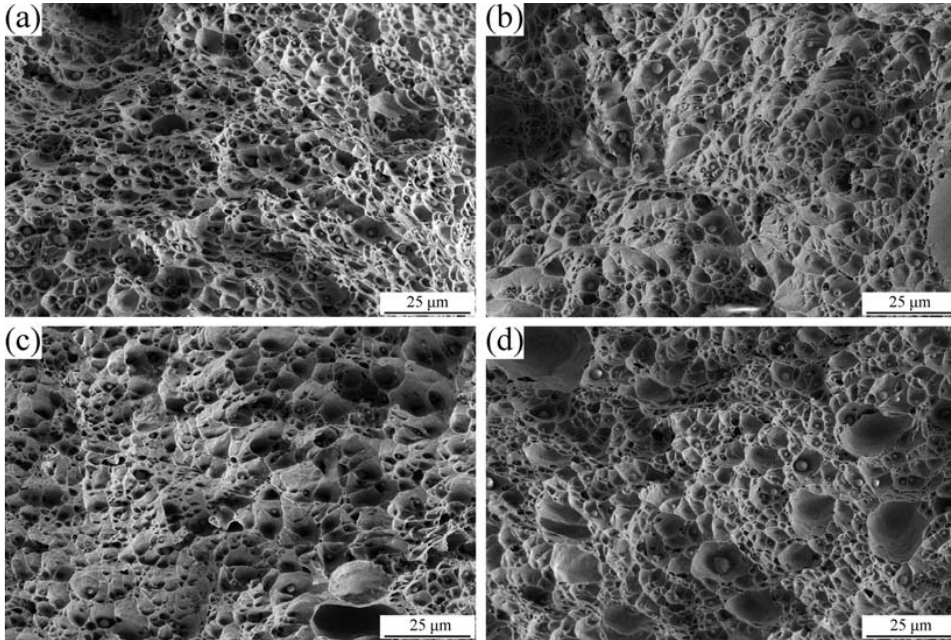
Figure 16. Impact fracture surface with different excitation voltage at a constant pulse frequency of 30 kHz: ( a ) 0 V; ( b ) 20 V; ( c ) 40 V; ( d ) 60 V.